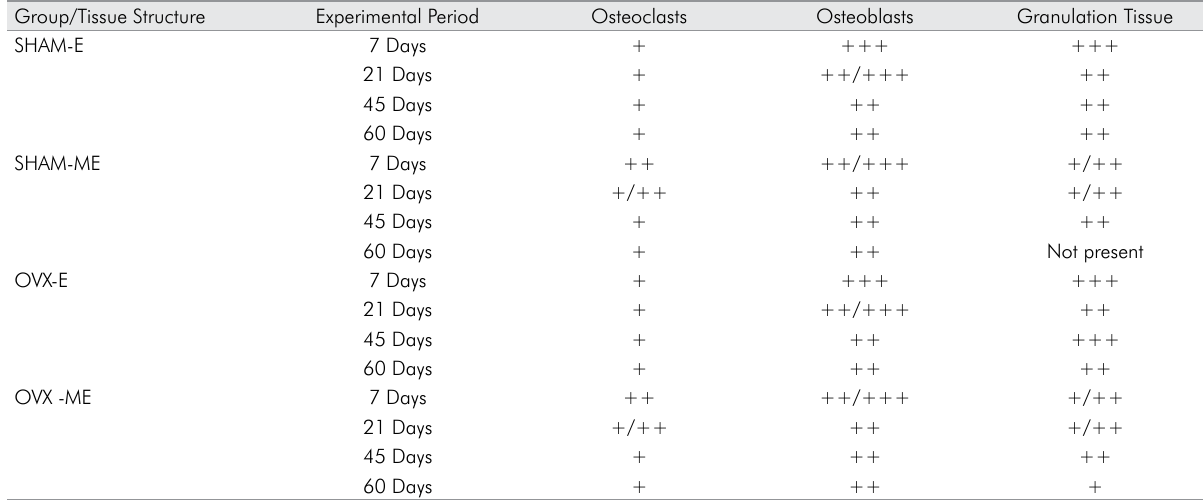
Table 2. Summary of RANK-L results Group/Tissue Structure